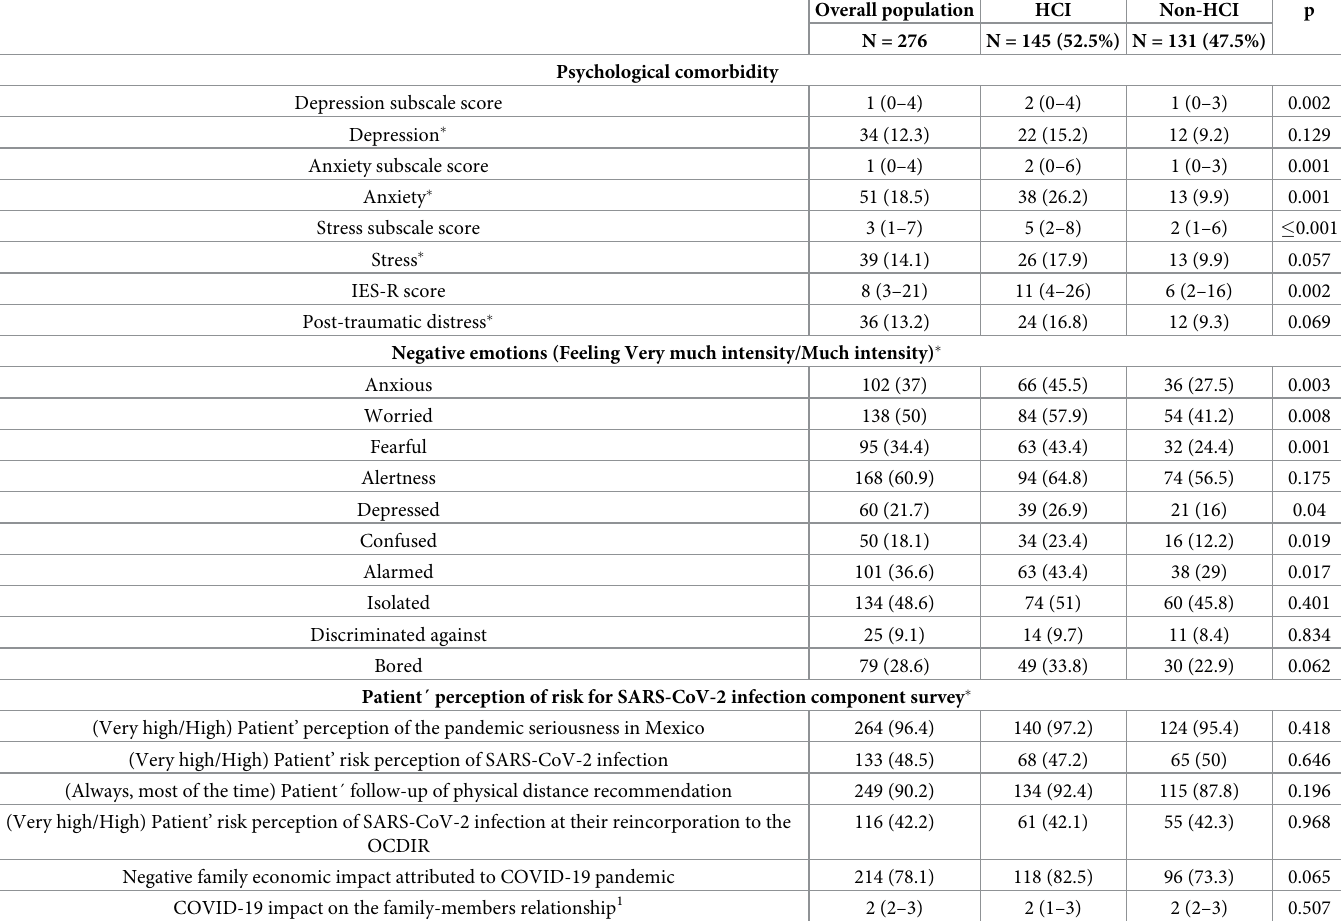
Table 2. Characteristics of the population and their comparison in the subpopulations defined according to HCI/non-HCI: Psychological comorbidity, negative emotions and patient´ perception of risk for SARS-CoV-2 infection component